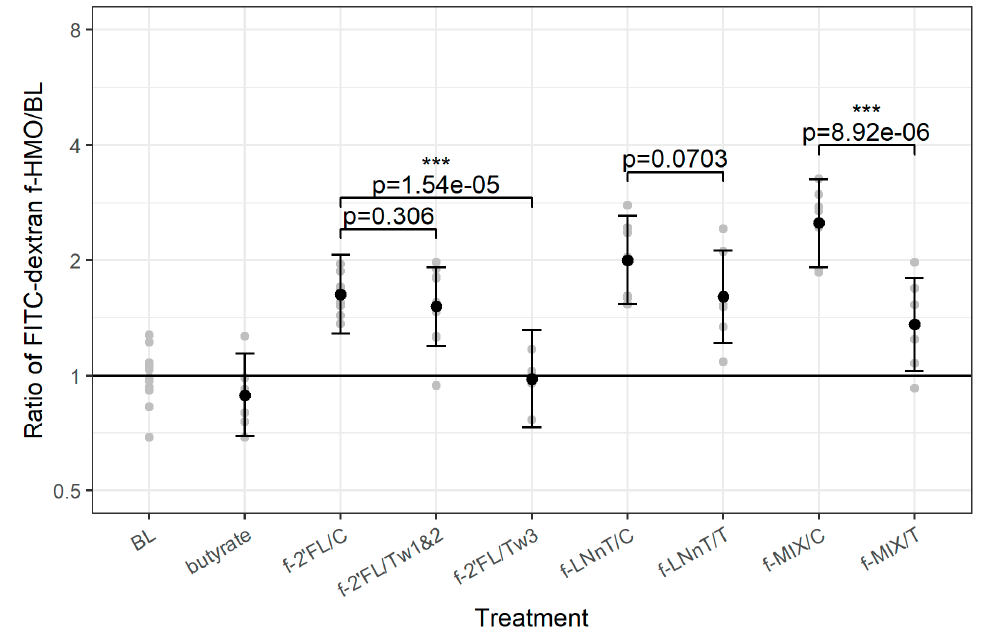
Figure 3. Effect of f-HMO treatment on FD4 permeability on Caco2 cells. The data show results for FD4 concentration in basolateral medium (µg/mL) of f-2’FL/C, f-2’FL/Tw1&2, f-2’FL/Tw3, f-LNnT/C, f-LNnT/T, f-MIX/C, and f-MIX/T, medium-only treated Caco2 cells (BL) and butyrate as the control. Comparison of FD4 permeability for each f-HMO to BL is shown. Grey points represent individual replicates. Black points and error bars (95% confidence levels) represent estimates of treatment effect as compared with BL, with outcomes scaled such that the horizontal line at y = 1 represents the average BL level. p-values correspond to pairwise comparison of FD4 permeability for each of the following f-HMO sample pairs: f-2’FL/C versus f-2’FL/Tw1&2, f-2’FL/C versus f-2’FL/Tw3, f-LNnT/C versus f-LNnT/T, and f-MIX/C versus f-MIX/T. The p -values shown for each treatment vs. control comparison are FDR corrected (see text for details). *** shown for p < 0.001.